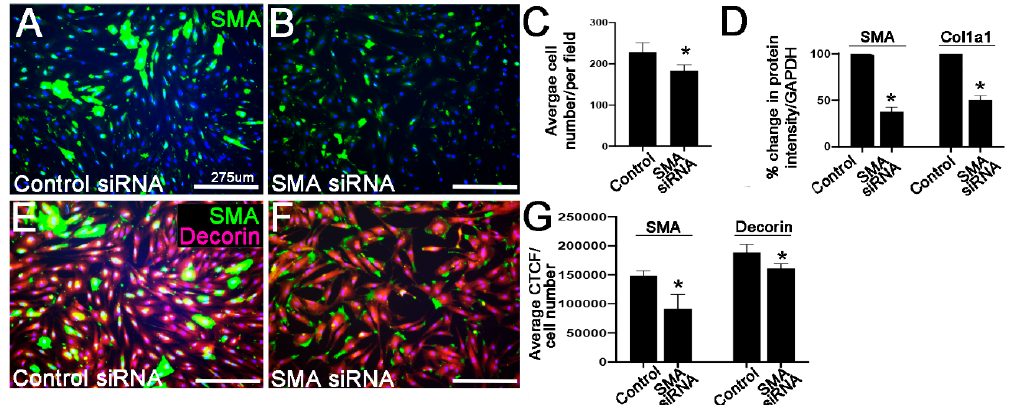
Figure 3. Reduction in α -smooth muscle actin (SMA) by siRNA in porcine mitral valve interstitial cells (pmVICs) results in decreased Collagen I (Col1a1) and Decorin expression. ( A , B ) Immunohistochemistry of SMA in pmVICs treated with 75 nM control or SMA-targeted siRNA for 96 h; ( C ) average number of DAPI-positive nuclei in treated pmVICs, n = 3, * p > 0.05 using a Student’s t-test in SMA-siRNA treated cells compared to control-siRNA; ( D ) percent change in protein intensity following Western Blot analysis of SMA (5 μ g protein blot) and Col1a1 (20 μ g protein blot) expression normalized to GAPDH in pmVICs treated with SMA siRNA compared to controls, n = 9, * p > 0.05 using a Student’s t-test; ( E , F ) immunohistochemistry of SMA (green) and Decorin (red) in pmVICs treated with 75 nM control or SMA-targeted siRNA for 96 h; ( G ) Corrected Total Cell Fluorescence (CTCF) quantification of SMA and Decorin immunoreactivity normalized to cell number, n = 3, * p > 0.05 using a Student’s t-test.